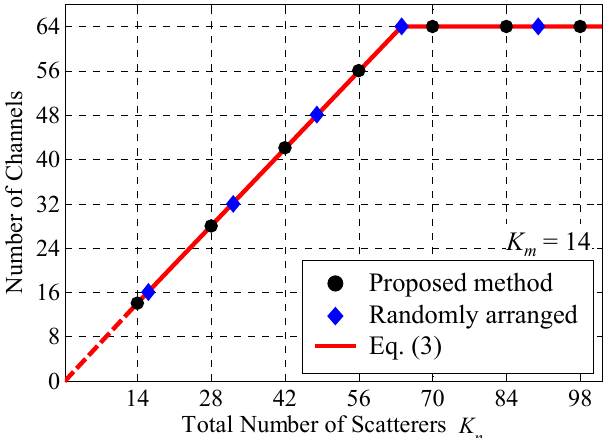
Figure 3. Number of channels vs. number of total scatterers.